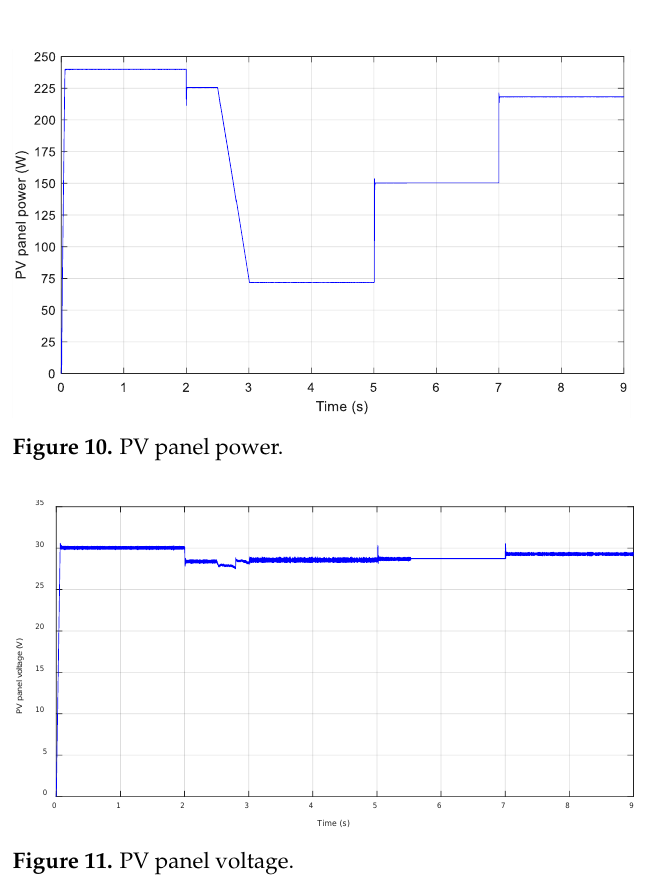
Figure 11. PV panel voltage. The DC-link voltage is shown in Figure 12. It is well regulated and its values change according to the weather conditions. Figure 13 presents the SPUC5 capacitor voltages. They are properly controlled and maintained at half of the DC-link voltage.